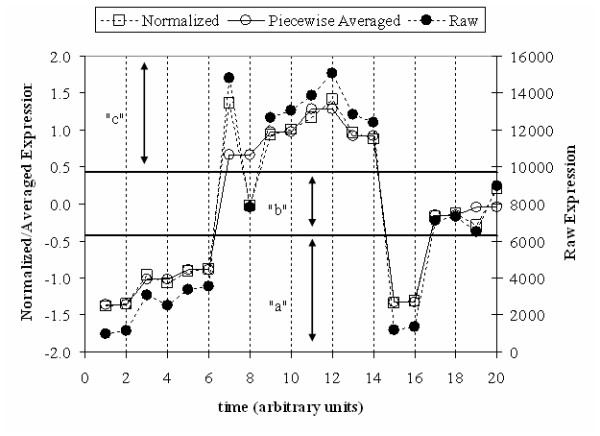
An example of a HOT-SAX transformation of a time series (w = 2, α = 3).